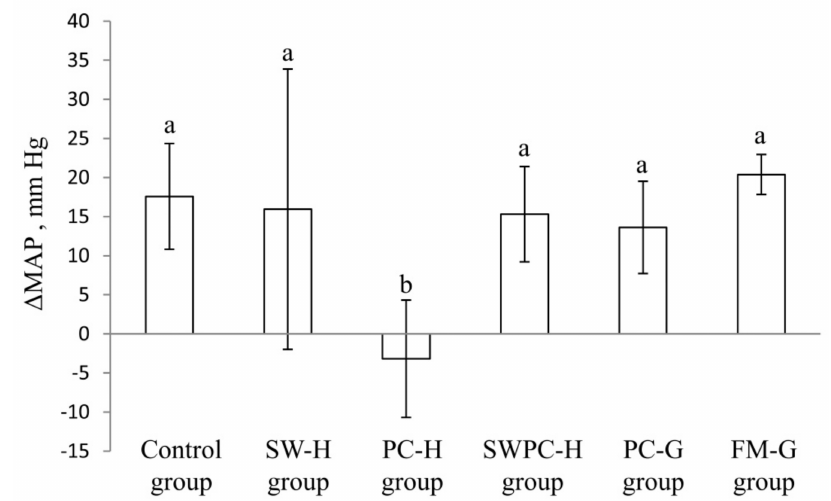
Figure 1. Changes in mean arterial pressure (MAP) from baseline to endpoint. Values are means, with standard error of mean represented as vertical bars. Values are shown for n = 8 in control group, n = 5 in SW-H, and n = 6 in all other groups. Groups are compared using one-way ANOVA with LSD post hoc test. Bars with different letters are significantly different ( p < 0.05). BP; blood pressure, SW-H; stickwater from Havstrand, PC-H; presscake meal from Havstrand, SWPC-H; stickwater + presscake meal from Havstrand, PC-G; presscake meal from Granit, FM-G; fillet meal from Granit. Table 2. Mean arterial pressure (MAP) measured at baseline, Day 14 and at endpoint. Control SW-H PC-H SWPC PC-G Group Group Group Group